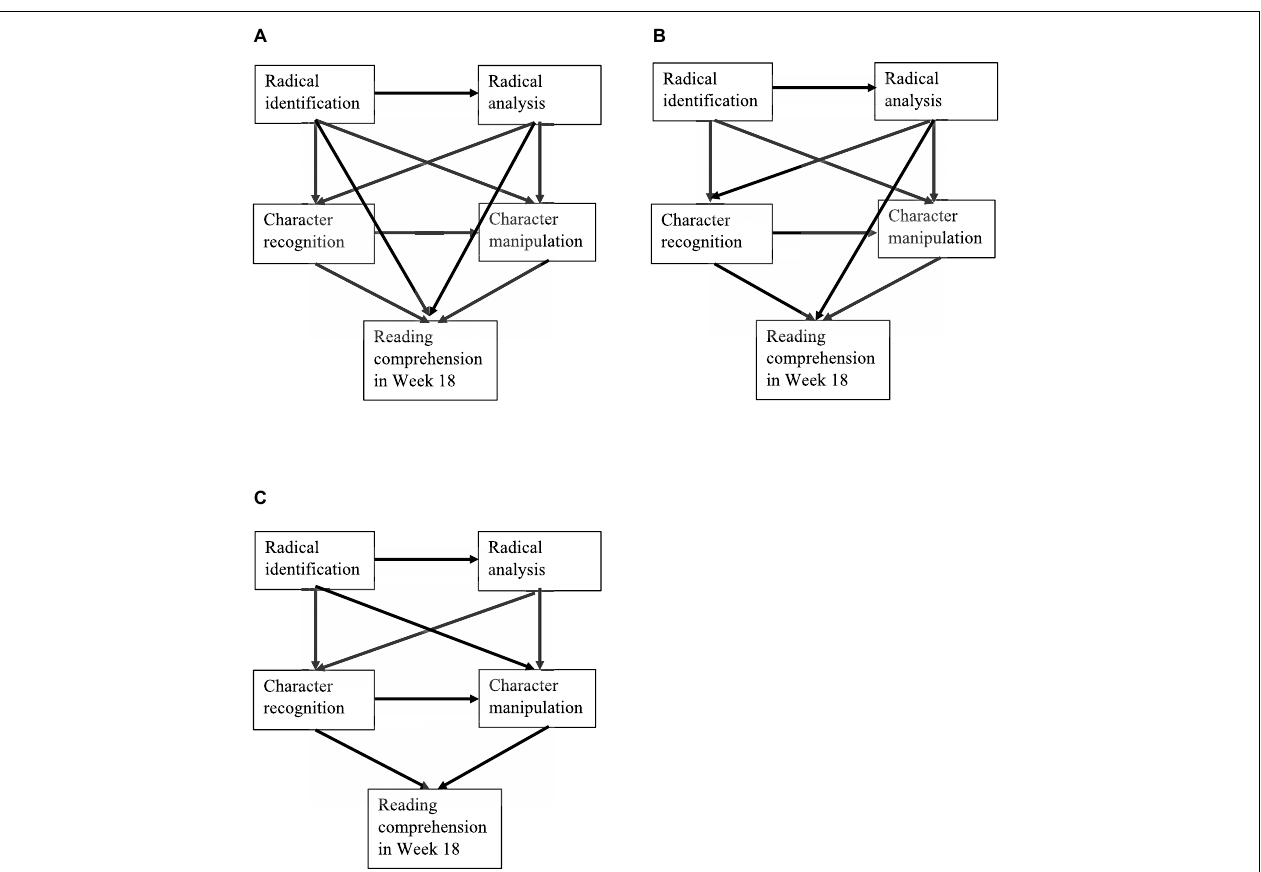
FIGURE 1 | Three different conceptual models (A–C) of the interrelationships among early radical-level and character-level grapho-morphological knowledge as well as later reading